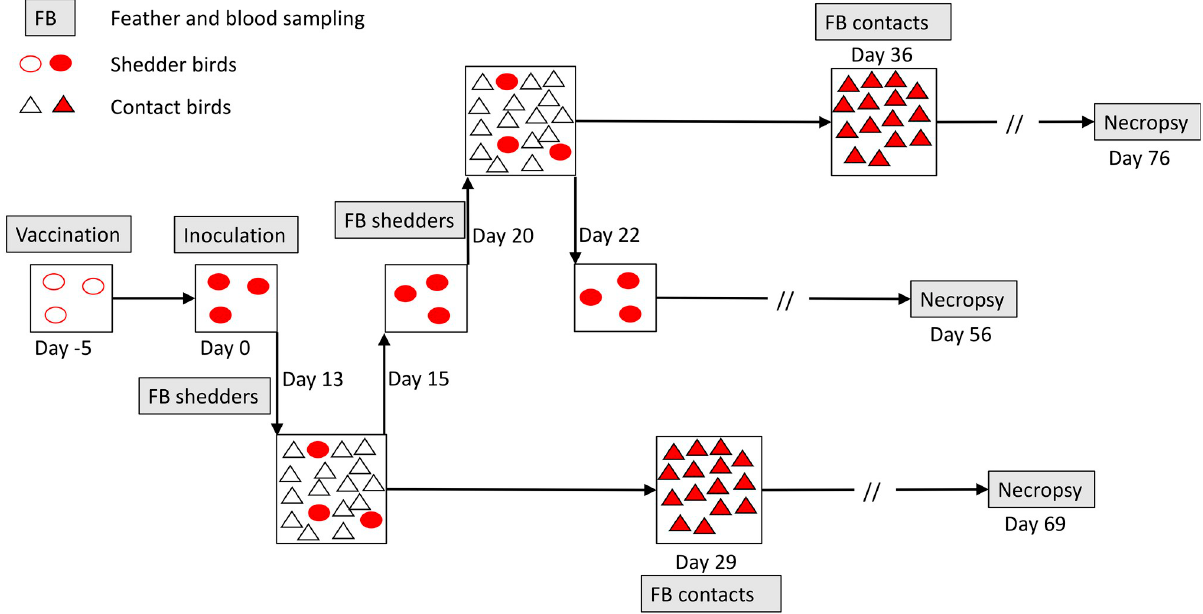
Fig 1. Schematic overview of one ‘lot’ (2 lots per replicate, 1 for each shedder vaccination status) of the MD transmission experiment. In each lot, shedder birds were all either HVT-vaccinated or PBS sham-vaccinated. All contacts were unvaccinated. The experiment comprised 16 replicates, each consisting of 1 lot in which 3 infected vaccinated shedders were placed in 48-hour contact with 15 na ï ve unvaccinated contacts at 2 time points, and 1 equivalent lot with sham-vaccinated shedders (4 additional sham-vaccinated lots were added because 2 of these had only 2 shedders because of early death). In total, there were 1,080 contacts and 106 shedder individuals distributed into 72 contact bird groups. Contact bird groups each had roughly equal numbers of males and females. All indicated time points (not to scale) are relative to the day of shedder inoculation with wild-type virus. Open and closed symbols represent uninfected and infected chickens, respectively. For all birds, necropsy was carried out to determine the presence and severity of disease symptoms (tumours and peripheral nerve enlargement) at 8 weeks post-infection (shedders) or post-contact (contact birds), or upon death/euthanasia, whichever was the sooner. HVT, herpesvirus of turkeys; MD, Marek disease; PBS, phosphate buffer solution.